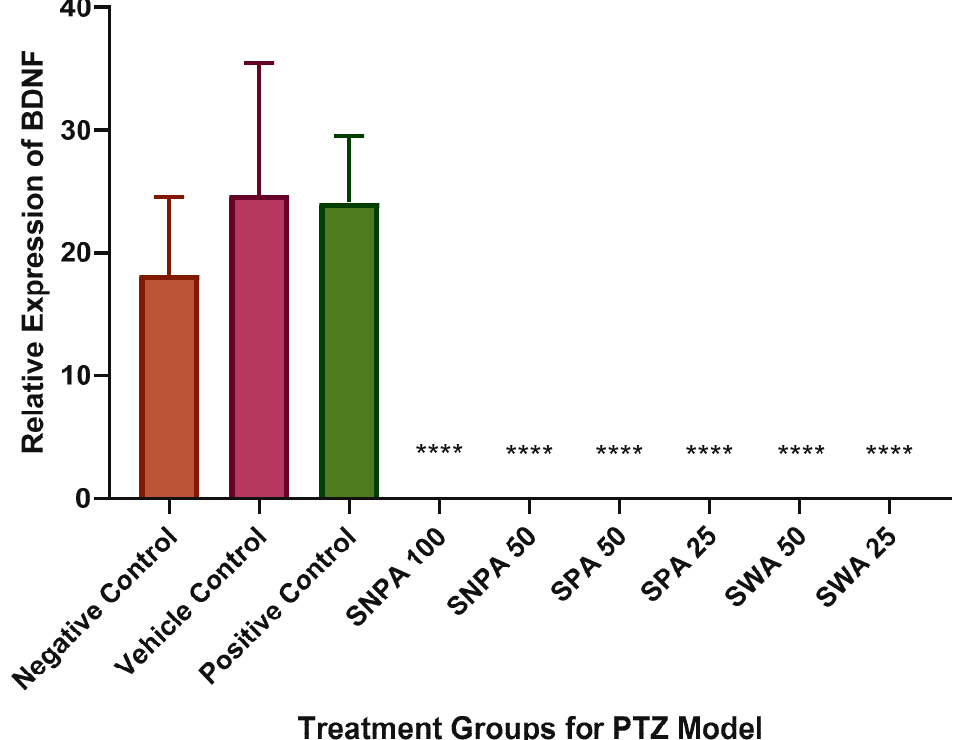
Figure 4. Graphical representation of mean seizure onset for score 4 in various groups of PTZ model. The data was compared to the negative control group using one-way ANOVA (* p < 0.05; ** p < 0.01). The figure represents mean ± SEM of seizure onset time ( n = 10).